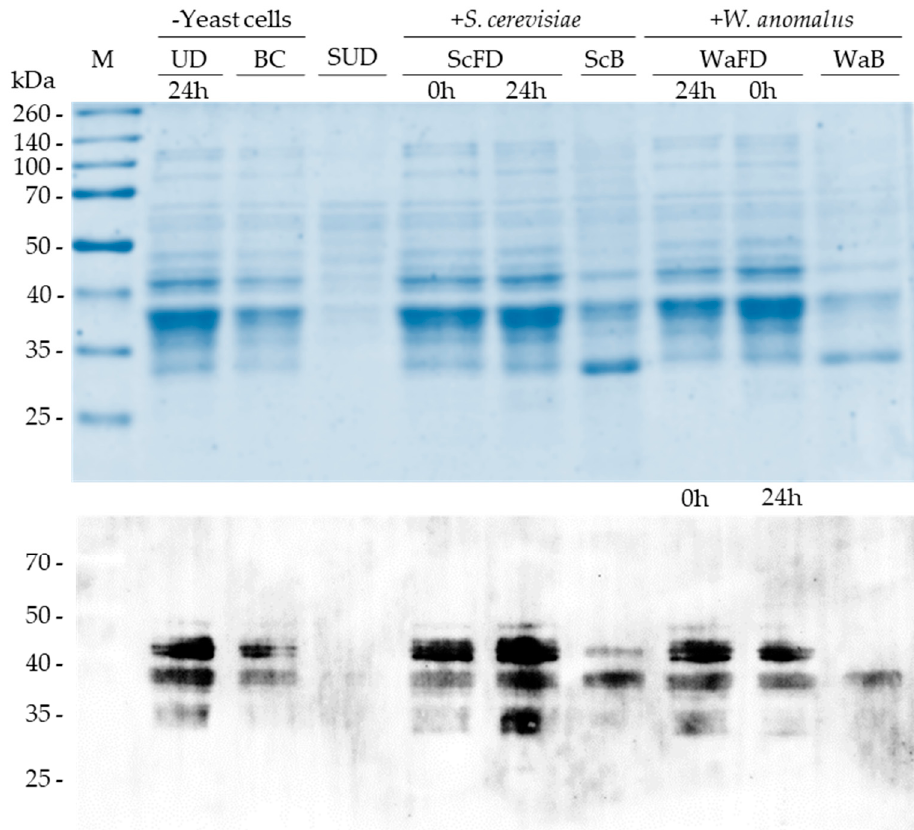
Figure 7. Detection of α -gliadin proteins in fermented dough and bread. The top image corresponds to the SDS-PAGE analysis of the gliadin fraction extracted from the dough and the bread shown previously (Figure 6). UD, unfermented dough; ScFD and WaFD, S. cerevisiae - and W. anomalus - fermented dough, respectively; BC, ScB, and WaB, bread obtained after dough UD, ScFD and WaFD were baked, respectively. The protein fraction of the soybean unfermented dough (SUD) was included as a negative control. The time at which the dough samples were taken is indicated. In the lower part, the immunodetection of the α -gliadins contained in each sample is shown. The monoclonal anti- α -gliadin antibody [14D5], which recognizes an amino acid sequence of the α -gliadin immunogenic peptide 33-mer, was used. Note that WaFD samples were loaded in a different order in the SDS-PAGE than the immunoblot.